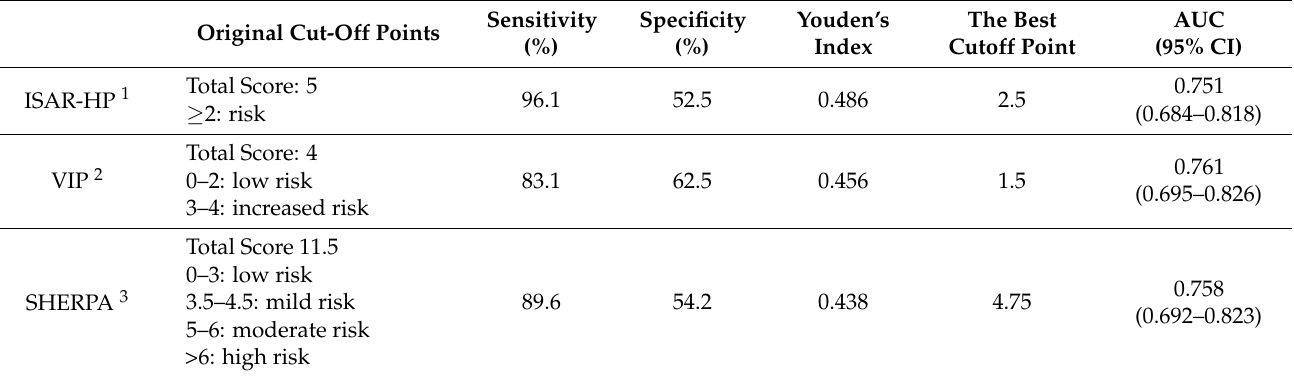
Figure 2. Area under the receiver operating characteristic for ISAR-HP, VIP, and SHERPA. Table 2. The predictive values of three screening instruments predicting functional decline in older hospitalized